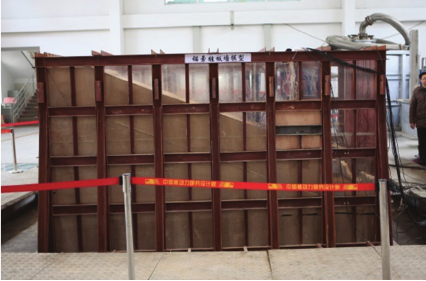
Figure 4: Shaking table test of retaining wall.